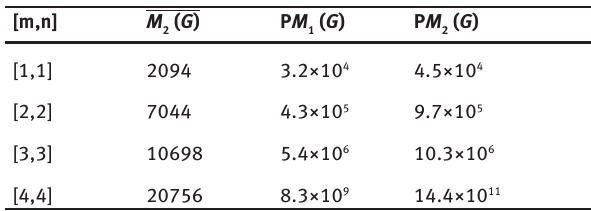
Table 4: A comparison of Zagreb coincides and multiple indices Si C 2 3